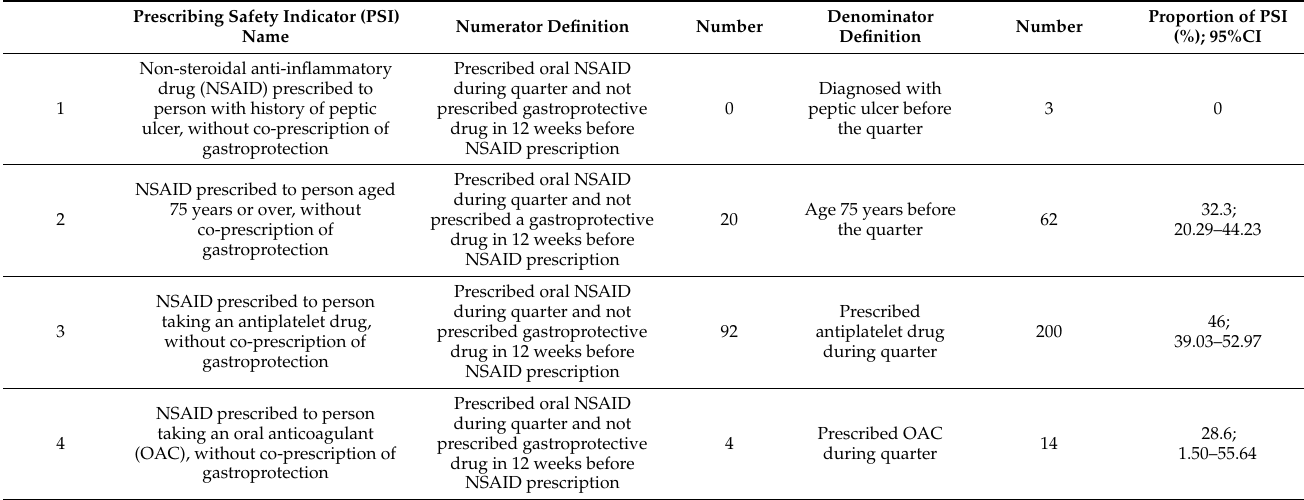
Table 2. Proportion of prescribing safety indicators and period prevalence at patient level (described using numerator, denominator, and percentage). (Adopted from Guthrie et al.